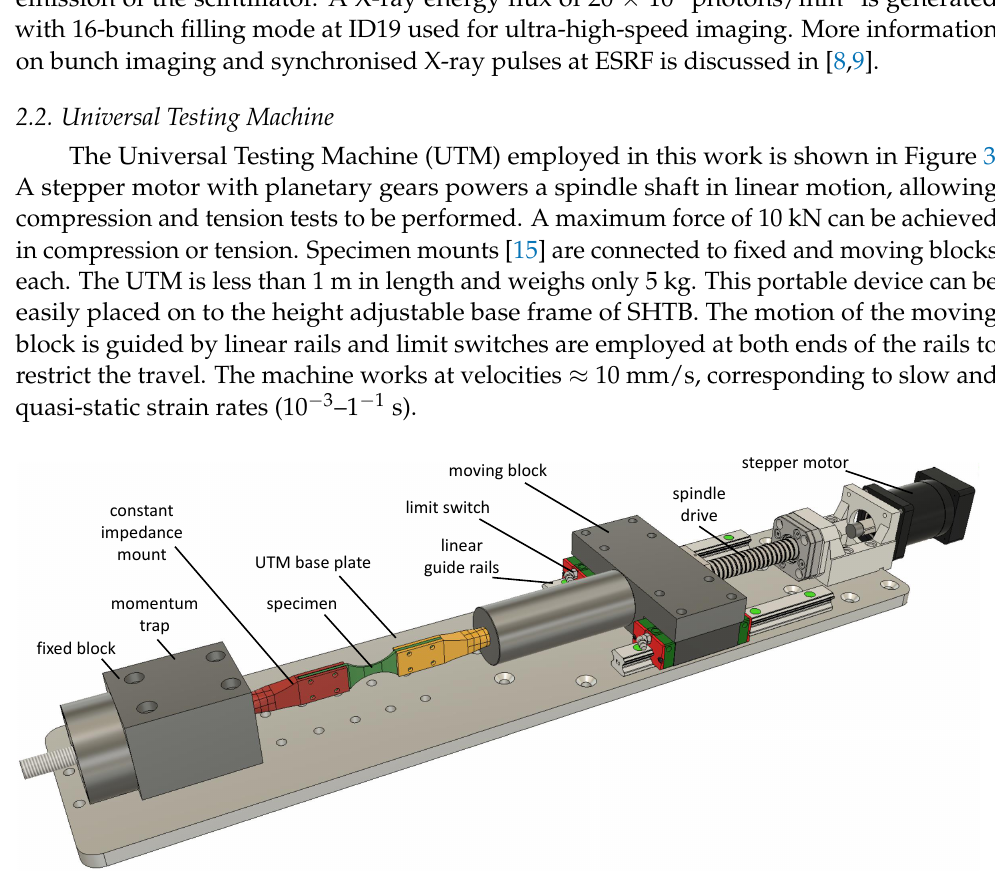
Figure 3. Sketch of the UTM setup employed in this